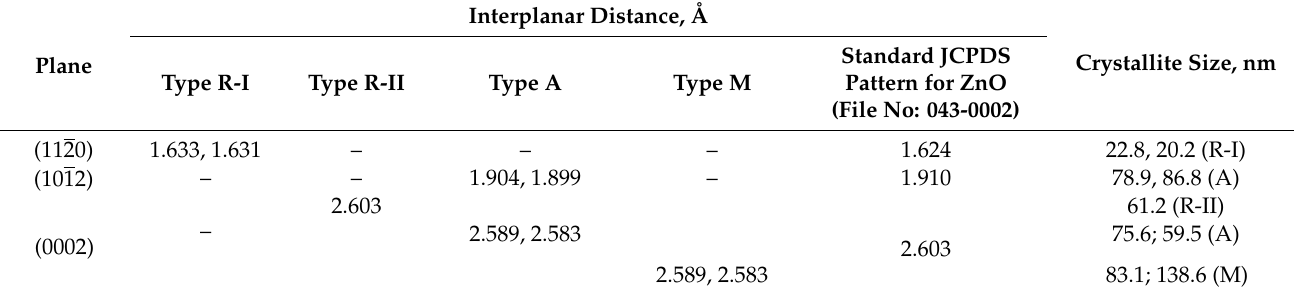
Table 1. Parameters of the crystal structure of ZnO